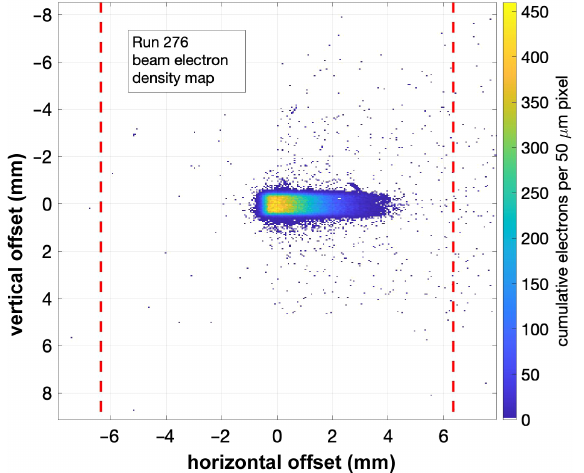
FIG. 6. Composite image of the beam primary electron dis- tribution arriving at the ePix 100 silicon detector, showing the pattern due to imperfect collimation of the beam arriving at End Station A. The vertical dashed lines show the location of the waveguide side wall inner edges.